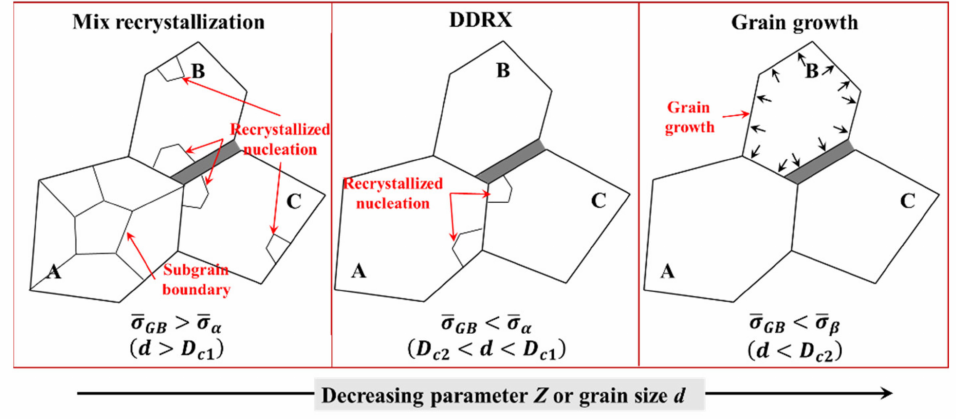
Figure 17. Schematic of transformative mechanisms of microstructure evolution under different hot deformation conditions of near- α titanium